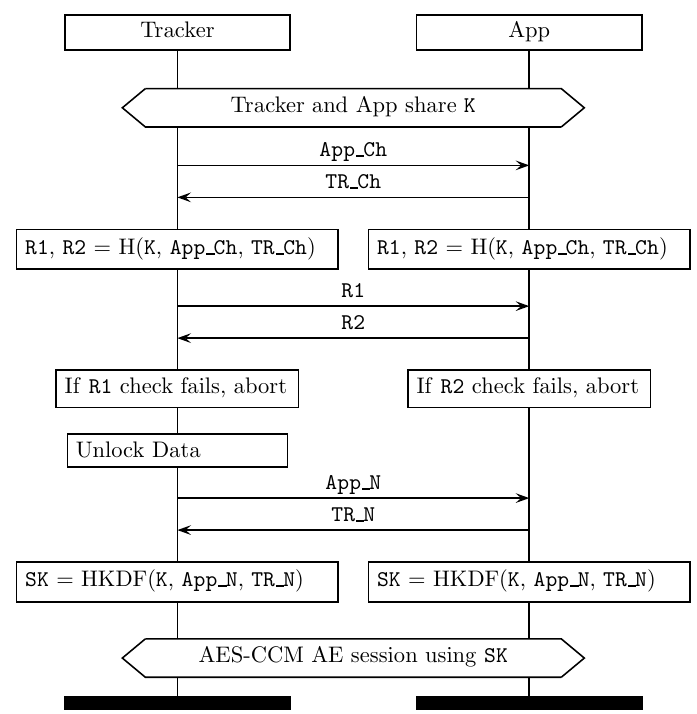
Figure 10: Mutual authentication protocol providing C3+C4. Tracker and app